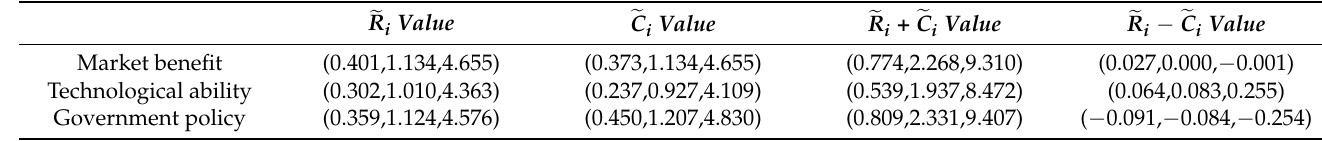
Table 1. Sum of (cid:101) R i value , (cid:101) C i value , (cid:101) R i + (cid:101) C i value and (cid:101) R i − (cid:101) C i value impacts of the three measurements.